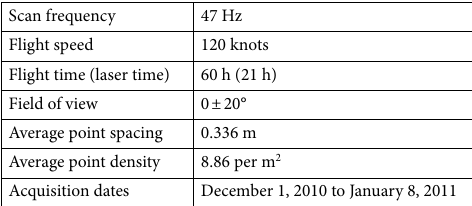
Table 3. The LiDAR acquisition parameters.